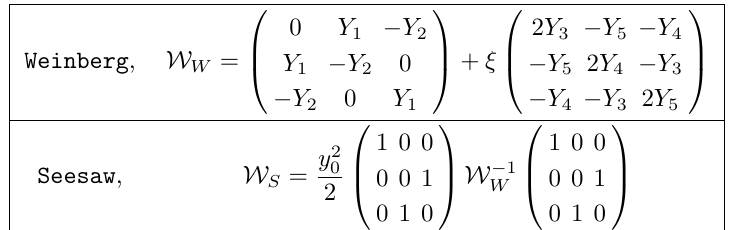
Table 2 . Relevant matrices in the neutrino sector of the superpotential in (cid:0) 4 models. where (cid:3) stands for the scale associated to lepton number violation, ( : : : ) representation of (cid:0) and (cid:24) is a free parameter. When light neutrinos get their masses 4